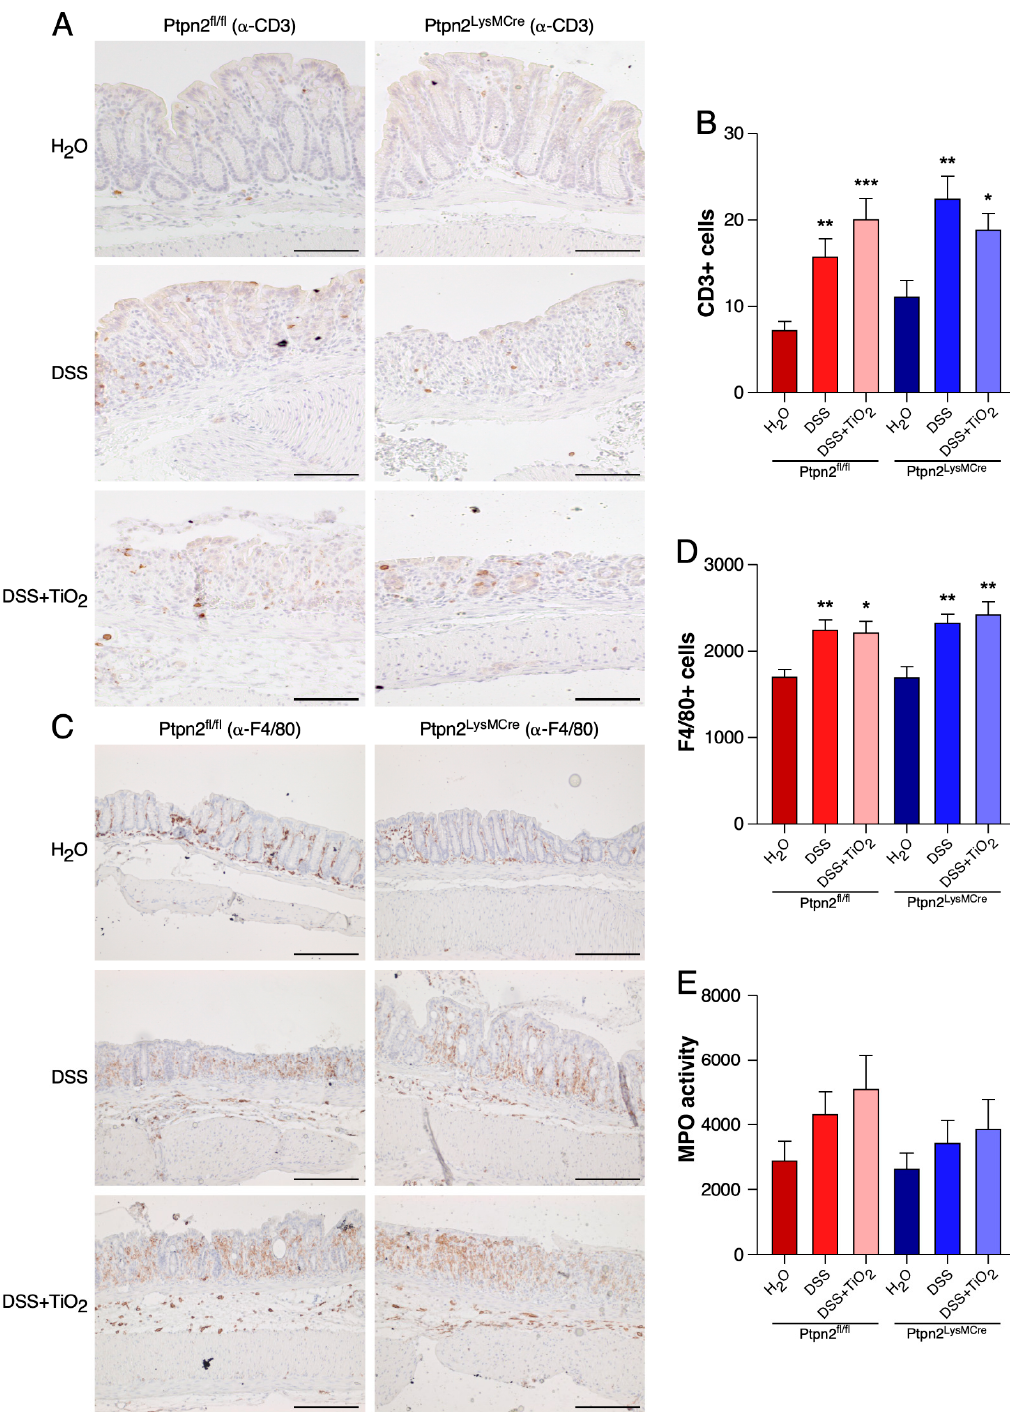
Figure 3. TiO 2 does not modulate total numbers of T cells, macrophages and MPO activity. ( A ) Representative IHC images of the colon from Ptpn2 fl/fl and Ptpn2 LysMCre mice stained with anti-CD3 during DSS-acute colitis under the indicated treatments. ( B ) Quantification of the CD3 cells of IHC from Ptpn2 fl/fl and Ptpn2 LysMCre mice during DSS-acute colitis under the indicated treatments. C. Representative IHC images of the colon from Ptpn2 fl/fl and Ptpn2 LysMCre mice stained with anti-F4/80 during DSS-acute colitis under the indicated treatments. ( D ) Quantification of the F4/80 cells of IHC from Ptpn2 fl/fl and Ptpn2 LysMCre mice during DSS-acute colitis under the indicated treatments. ( E ) Representation of the MPO activity in Ptpn2 fl/fl and Ptpn2 LysMCre mice during DSS-acute colitis under the indicated treatments. Data shown in panels ( C – E ) represent mean ± SEM. * p ≤ 0.05; ** p ≤ 0.01; *** p ≤ 0.001 relative to H 2 O of the same genotype. Scale bar: 100 µ